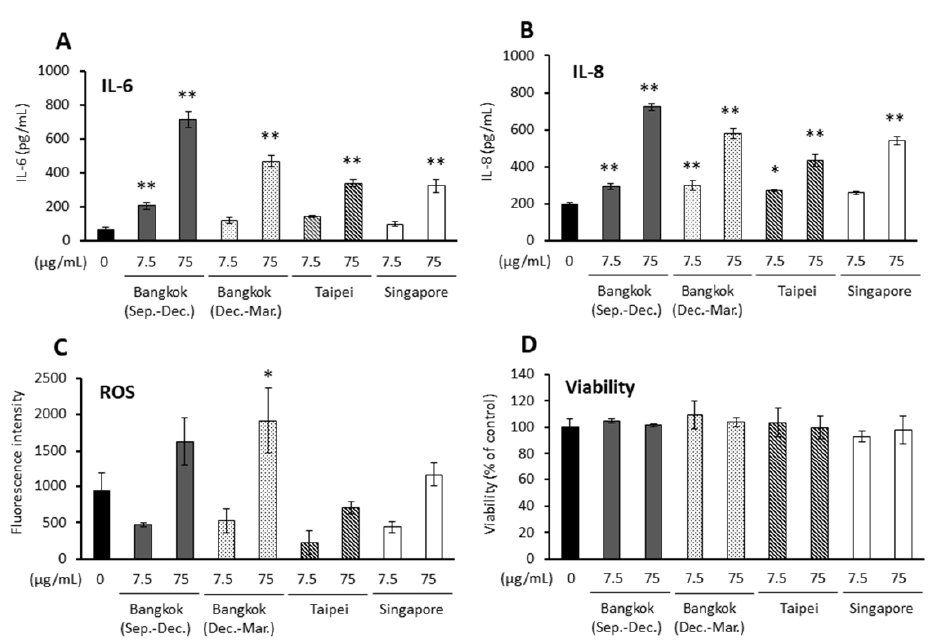
Figure 1. Effects of PM2.5 on proinflammatory responses, oxidative stress, and viability in BEAS-2B cells. ( A ) IL-6 release, ( B ) IL-8 release, ( C ) ROS production, ( D ) cell viability. * p < 0.05, ** p < 0.01 vs. 0 µ g/mL.